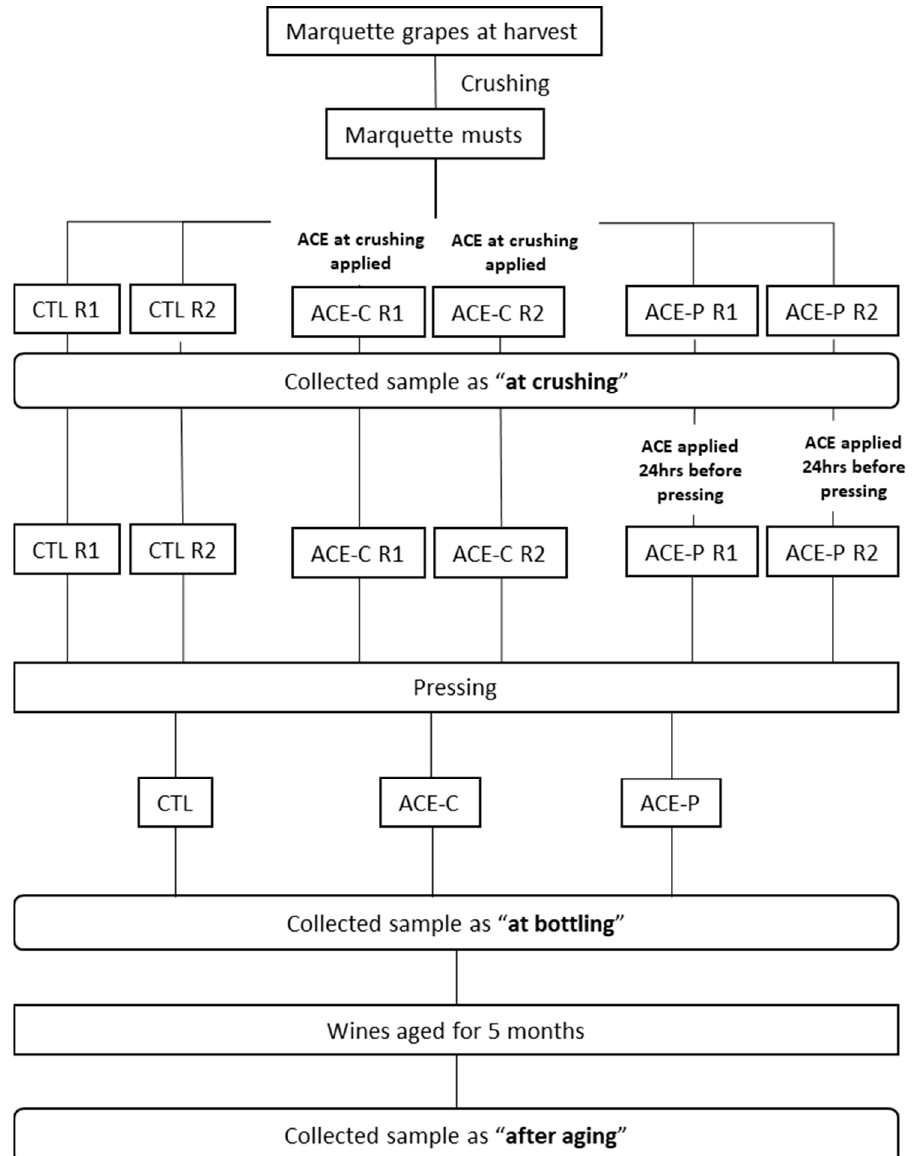
Figure 4. Flowchart of the winemaking protocols with three different treatments: control (CTL), ACE treatment directly after crushing (ACE-C), and ACE treatment 24 h prior to pressing (ACE-P) applied to the Marquette musts. Samples were collected at three time points: crushing, bottling, and after five months aging.